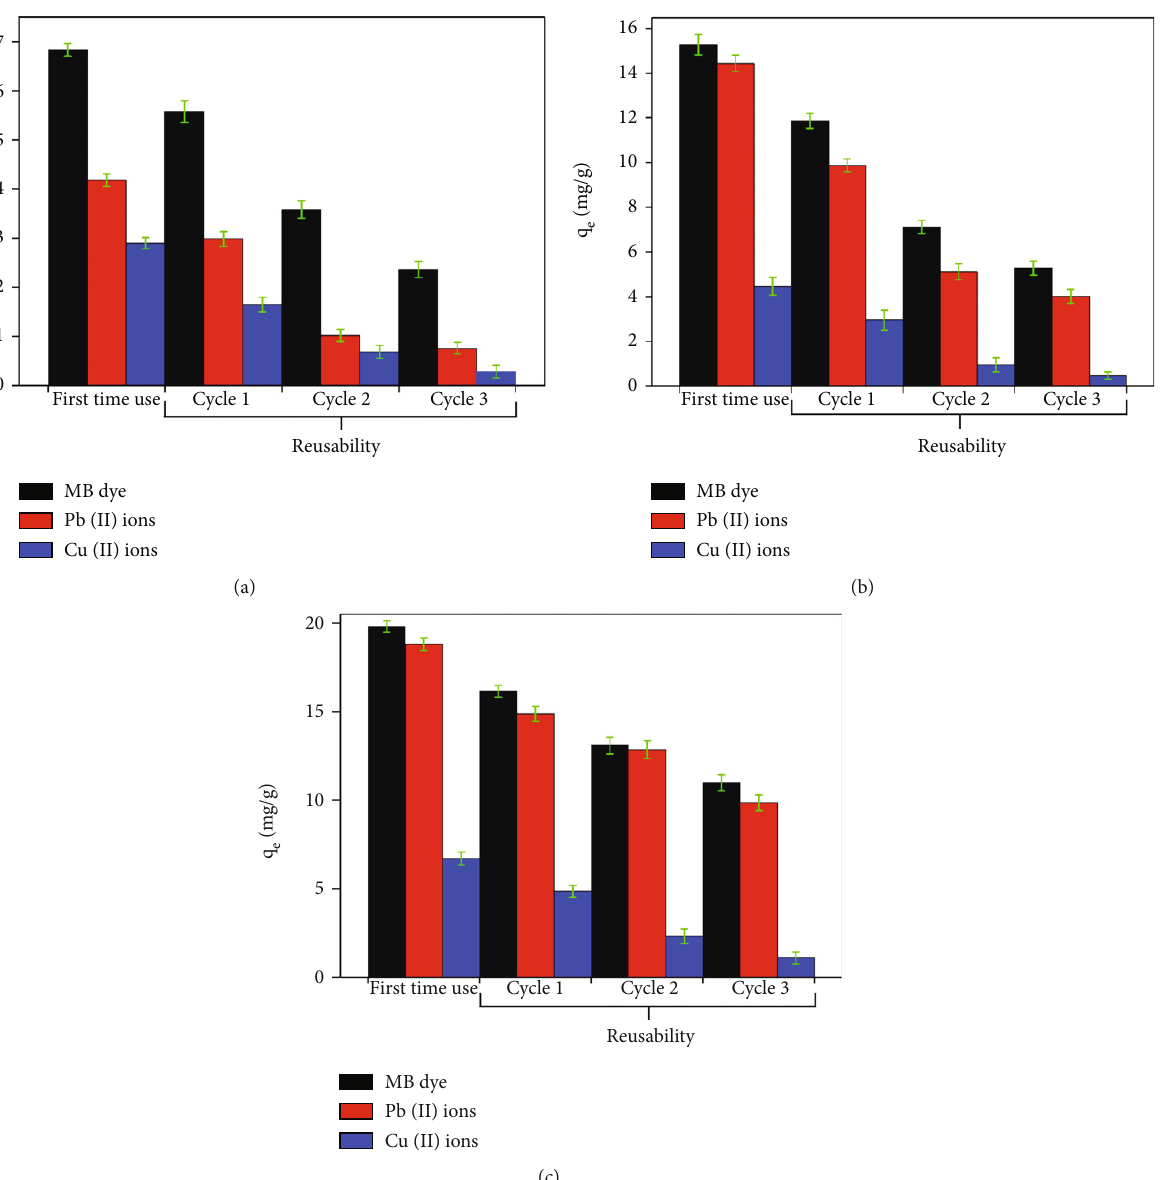
Figure 12: Reusability test of pure (a) PFS and treated (b) NAFS and (c) SAFS fennel seed adsorbents towards the adsorption of Pb(II), Cu(II) ions, and MB